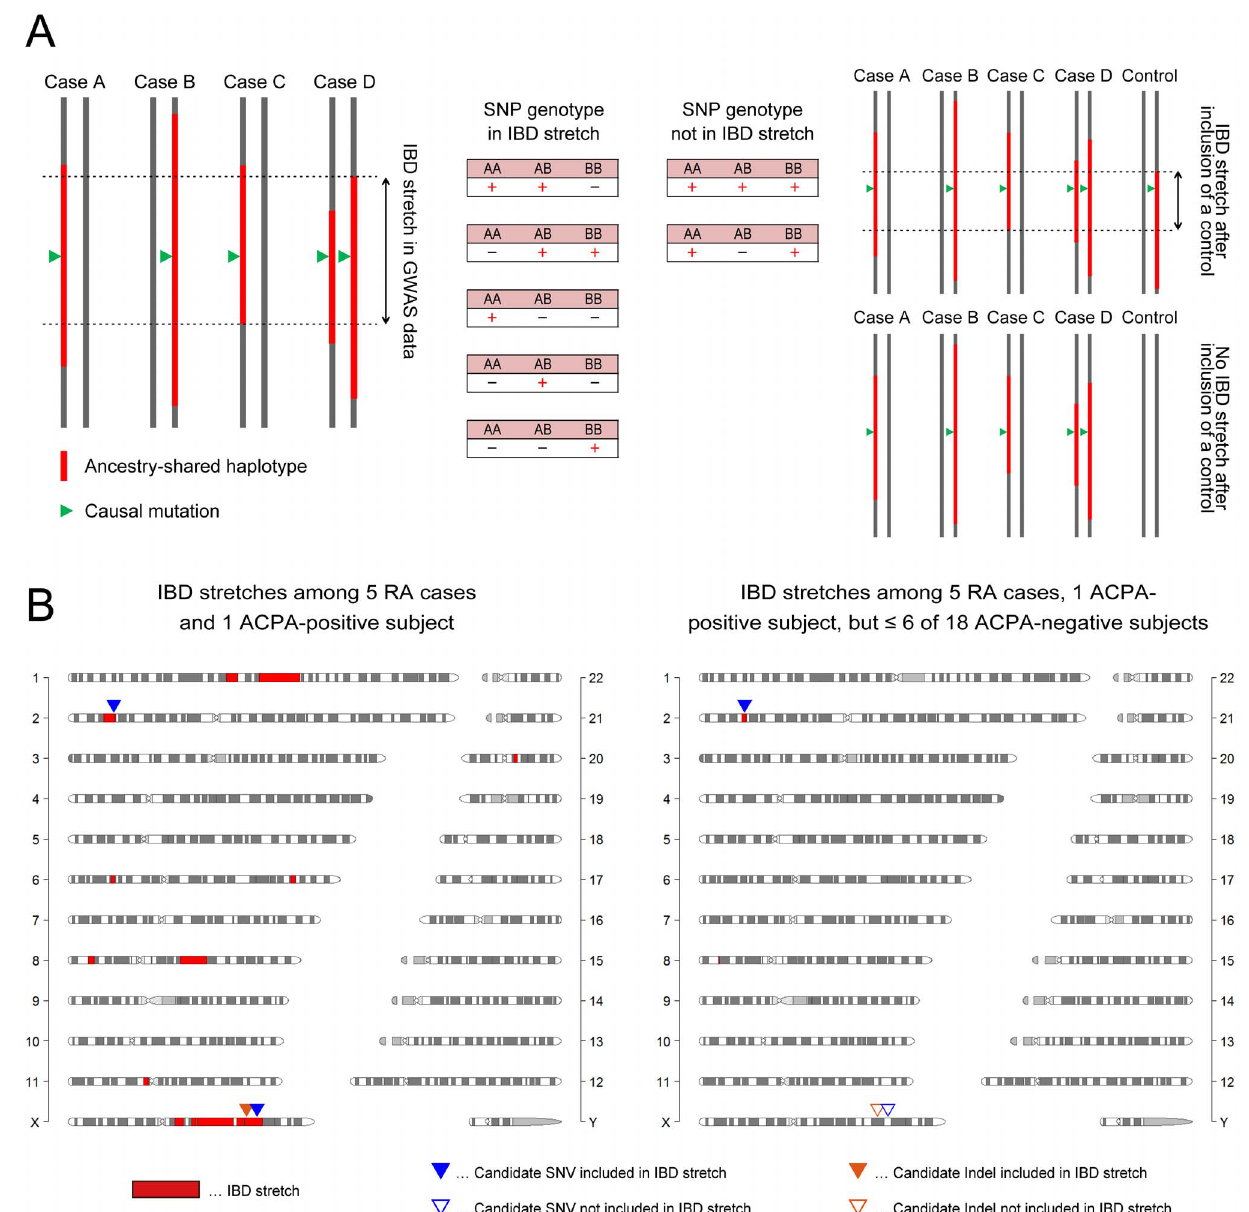
Figure 3. IBD mapping of the pedigree with RA. (A) We investigated the novel non-parametric linkage analysis method which enabled the IBD mapping for the disease with any types of inheritance modes. Affected cases should carry one or two copy of the mutation which resides on a single ancestral haplotype in IBD, thus, SNPs adjacent to the causal mutation lose homozygous genotypes for at least one of the alleles. Our method searched the regional IBD stretches where SNP genotypes of the affected cases followed this rule, and then imputed presence or absence of the ancestral haplotype in the other unaffected subjects separately. (B) Results of the IBD mapping in the consanguineous pedigree with RA. Mapped IBD stretches are indicated as the bands colored in red. As the pedigree members used for the IBD mapping increased (left panel; 5 RA cases and 1 ACPA- positive unaffected subject, right panel; all available subjects), IBD stretches narrowed down (see detailed process in Table S2). Candidate causal SNVs and Indels obtained after whole-genome exome sequencing were indicated as the triangles colored in blue and orange, respectively. The variants included and not included in the IBD stretches of each stages are indicated with filled and non-filled colors. Finally, only one SNV at 2p23 was included in the defined IBD stretch (right